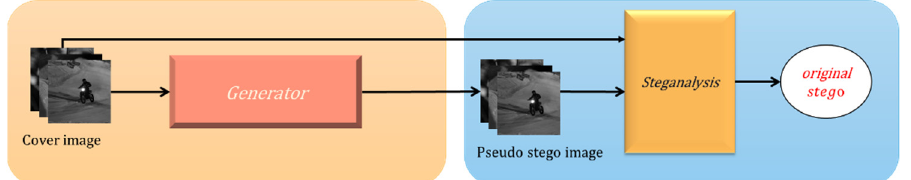
Figure 1. Architecture of the proposed GLSNet.